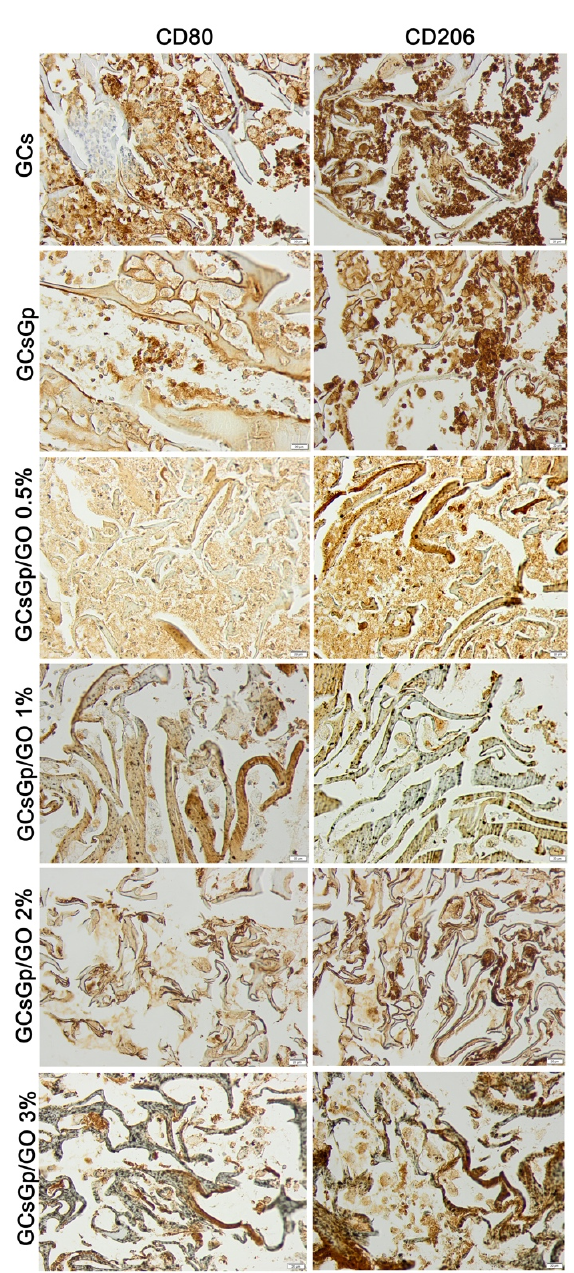
Figure 9. Immunohistochemical expression of CD80 and CD206 at week 4 post implantation for GCs, GCsGp, GCsGp/GO 0.5%, GCsGp/GO 1%, GCsGp/GO 2%, and GCsGp/GO 3%. GCsGp, GCsGp / GO 0.5%, GCsGp / GO 1%, GCsGp / GO 2%, and GCsGp / GO